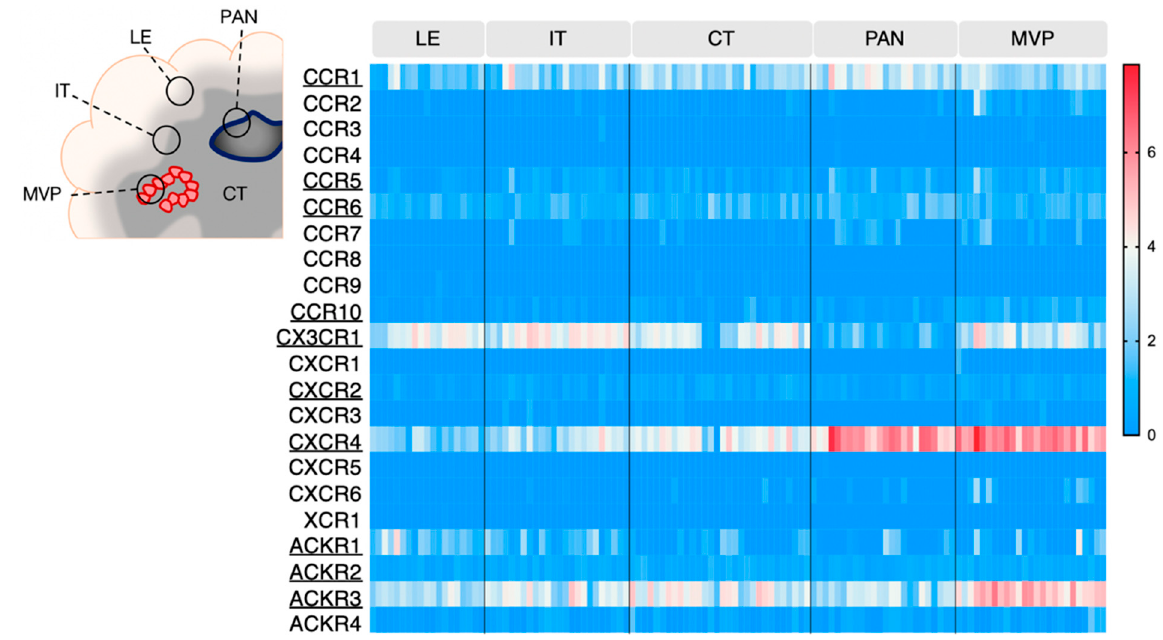
Figure 2. Chemokine receptor expression in various areas of GBM tumors (IvyGAP project). The heatmap displays log2 RSEM value for each receptor, in the various tumor subregions. Each cell represents one sample. Legend: LE: leading edge; IT: infiltrative tumor; CT: cellular tumor; PAN: pseudopalisading cells around necrosis: MVP: microvascular proliferation. Data is downloaded from https://glioblastoma.alleninstitute.org (accessed on 23 November 2021).